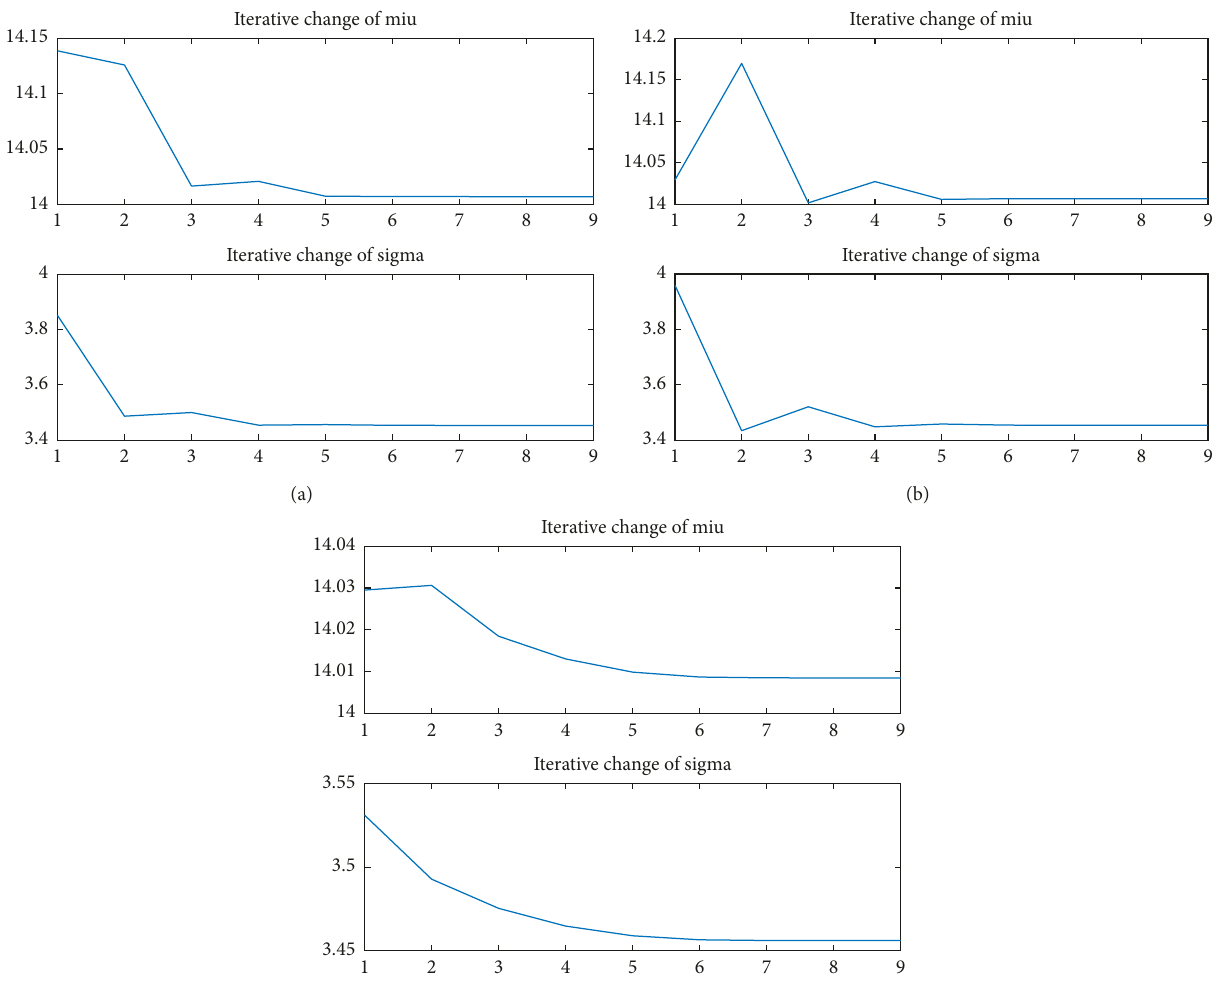
GP+TR . (b) VP KAU+TR . (c) VP RJF+TR .